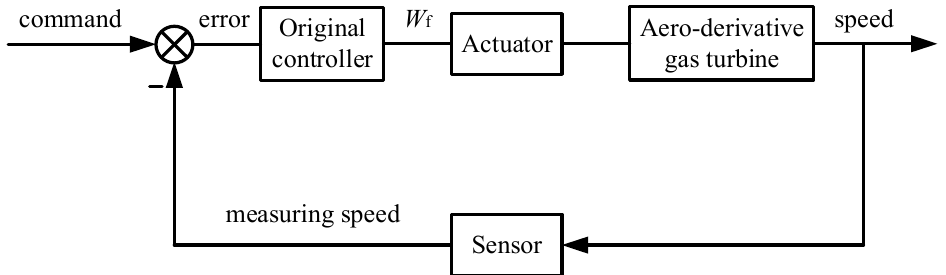
Figure 2. The entire control system of the aero-derivative gas turbine using the original controller.